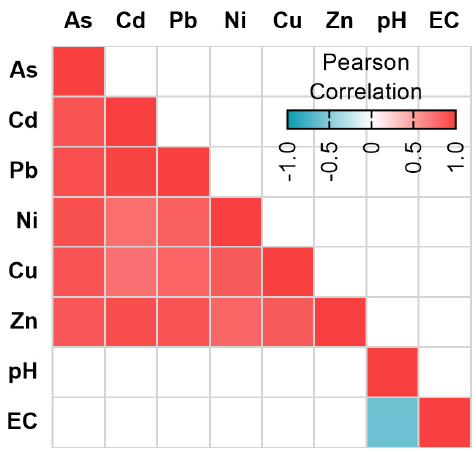
Figure 3. Correlation among metals and physicochemical parameters. The R correlation coefficient is represented in colors, as indicated in the legend. Only significant correlations ( p < 0.05) were included.